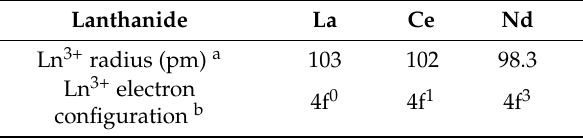
Table 2. Ln3+ radius (pm) and electron configuration of La, Ce, and